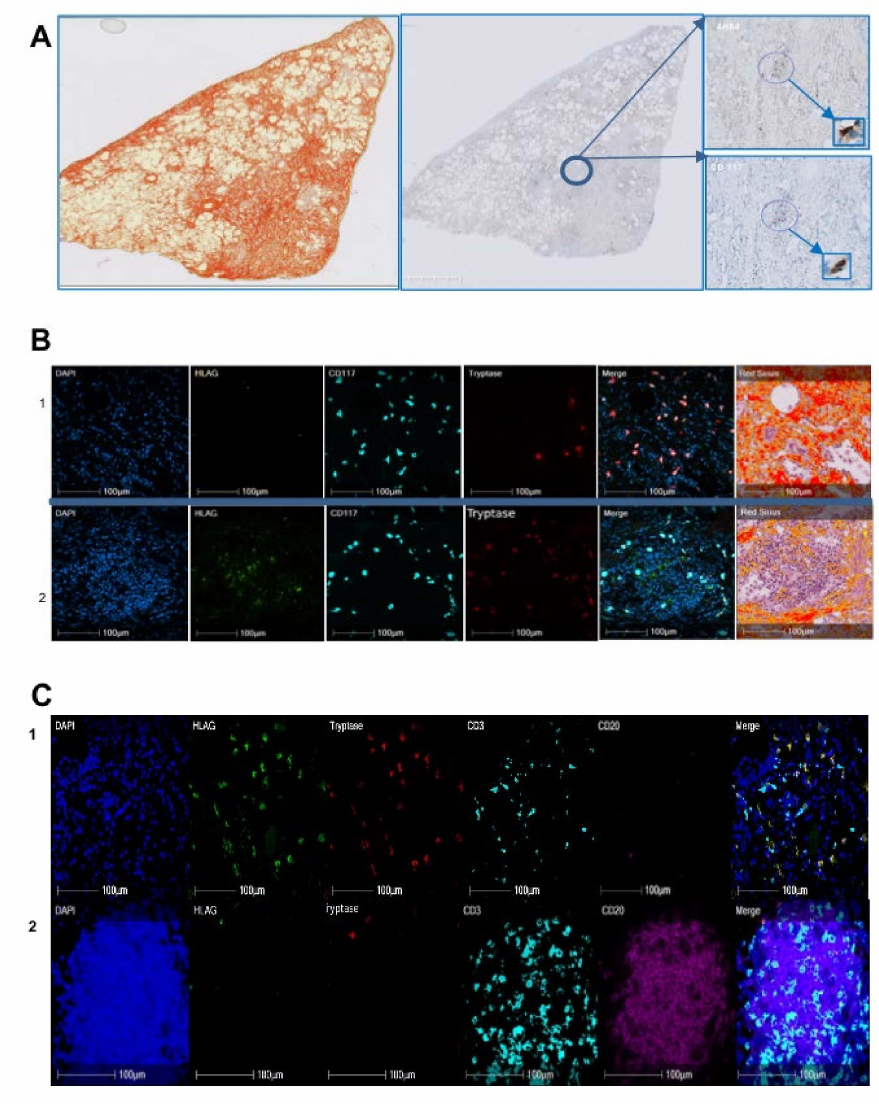
Figure 2. Nature of HLA-G cells on a representative case of IPF. ( A ) In the first paragraph, the photo on the left shows the Sirius Red coloration of one representative case out of ten IPF, the middle photo shows the counterstain by Mayer hematoxylin using immunohistochemistry. The areas in circles are topographically corresponding on HLA-G and CD117 stained slides with 4H84 recognizing HLA-G and CD117 antibody recognizing c-kit cells. The rectangles show a strong magnification of these areas, indicating that HLA-G cells do not match CD117 cells. ( B ) Quadruple immunofluorescence on a representative case of liver fibrosis out of two using DAPI with nuclei blue, HLA-G (with 4H84 antibody) with green pseudo-color, CD117 in cyan pseudo-color, mast cell tryptase in red pseudo-color, and the composite image or merge. On the right Sirius Red is represented; 1 and 2 are corresponding to two different areas of the lung, respectively the fibrosis span and cell node. ( C ) Quintuple immunofluorescence with DAPI, HLA-G with green pseudo-color, tryptase with red pseudo-color, CD3 with cyan pseudo-color, CD20 with fuchsia pink pseudo-color, on the same case of IPF shown in ( B ). ( C1 ) is corresponding to the ( B1 ) area. In ( C1 ), the majority of HLA-G cells is corresponding to mast cells in the fibrosis area, whereas very rare mast cells are HLA-G in the node shown in ( C2 ). The majority of the cells of the node are CD20. HALO analysis showed most of the HLA-G+ cells to be B